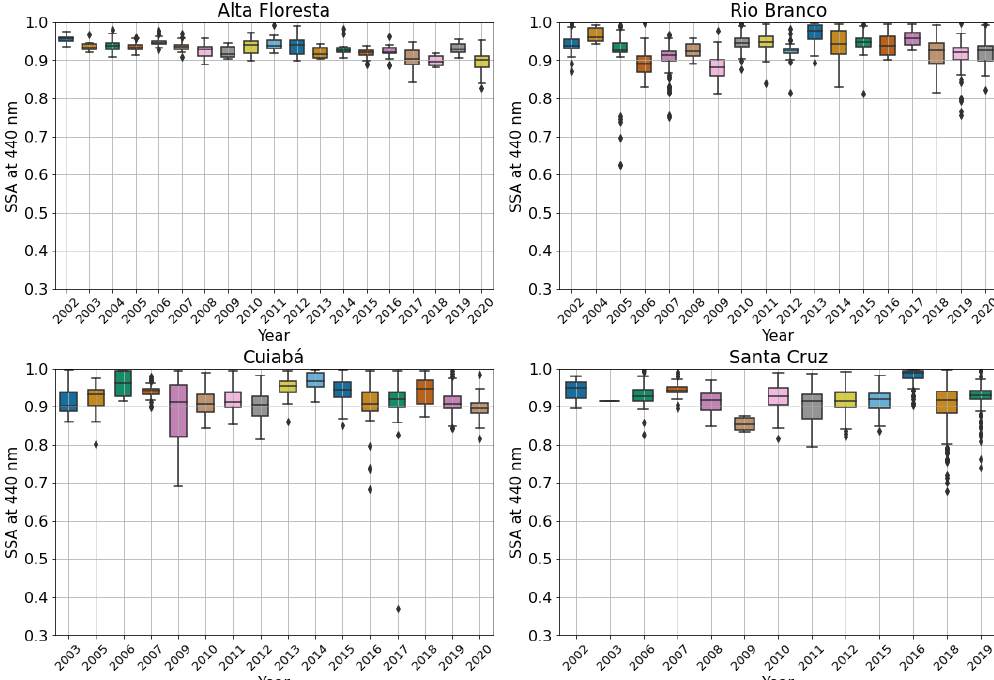
Figure 6. Multiyear box plots of the monthly single scattering albedo at 440nm (SSA at 440nm) from 2003 to 2020 for four AERONET sites, namely Alta Floresta, Cuiabá, Rio Branco, and Santa Cruz. In each box, the black line in the center represents the median, and the lower and upper limits are the first and the third quartiles, respectively. The vertical lines extending from the box represent the spread of instantaneous SSA at 440nm, with the length being 1.5 times the interquartile